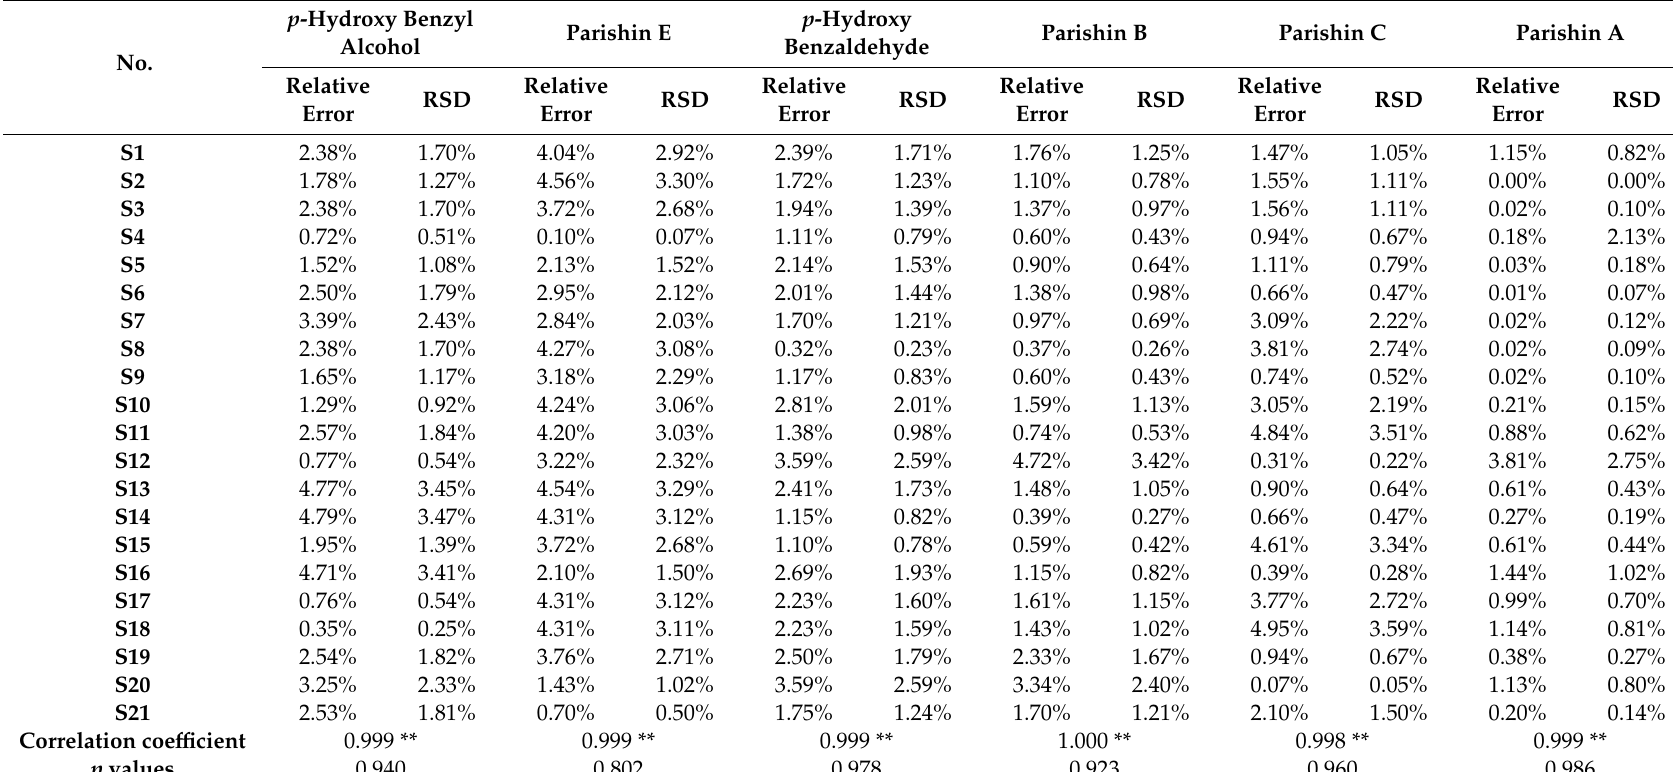
Table 7. The relative error, RSD, correlation coe ffi cient, and p values of the contents from the ESM and the QAMS 1